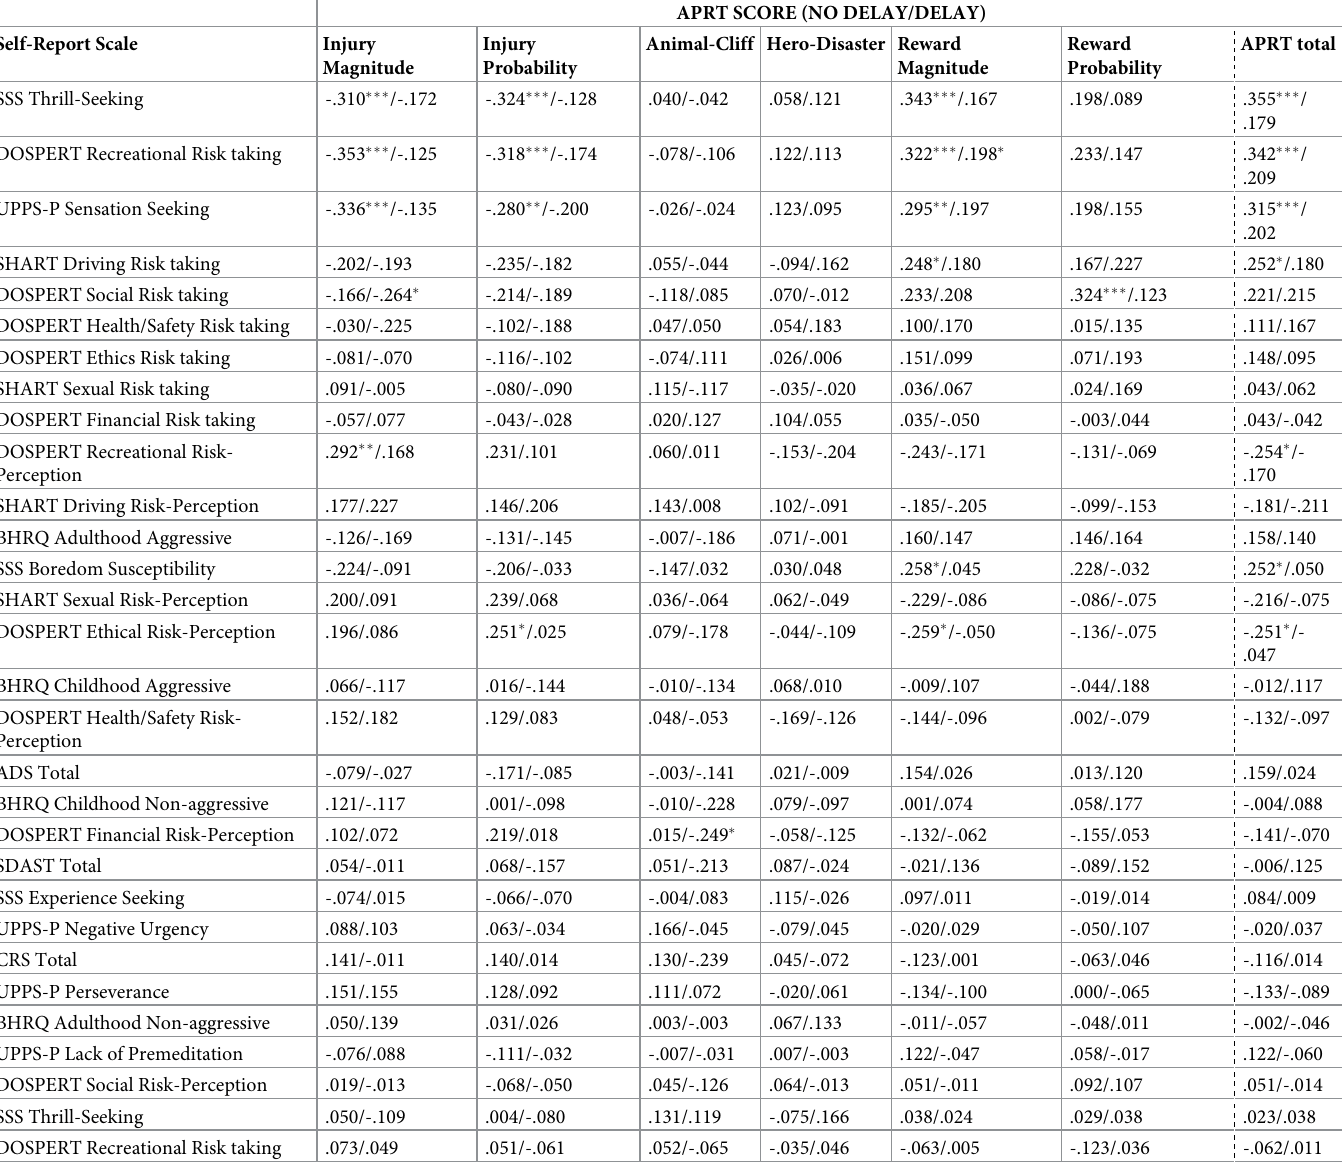
Table 5. Pearson correlations between APRT Points scores and self-report measures by delay